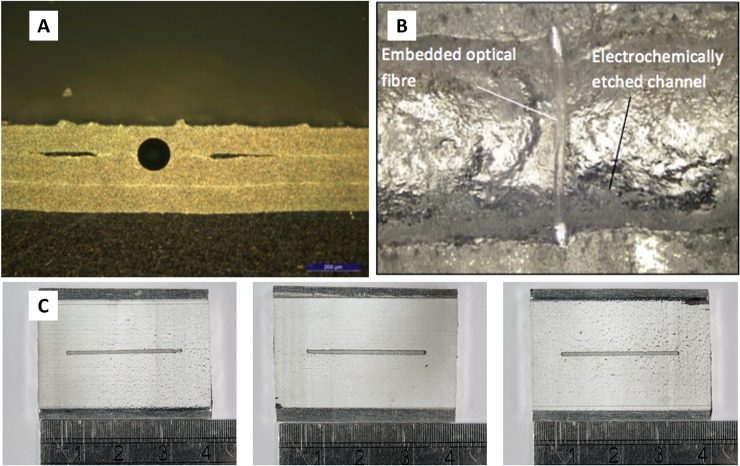
a) image of aluminium-coated optical fiber embedded via UAM b) exposed optical fibre exposed via electrochemical etching c) refined electrochemical etching results.